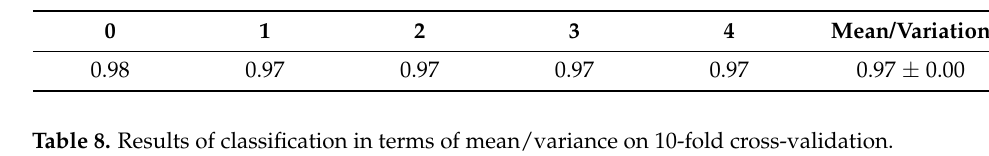
Table 8. Results of classification in terms of mean/variance on 10-fold cross-validation.